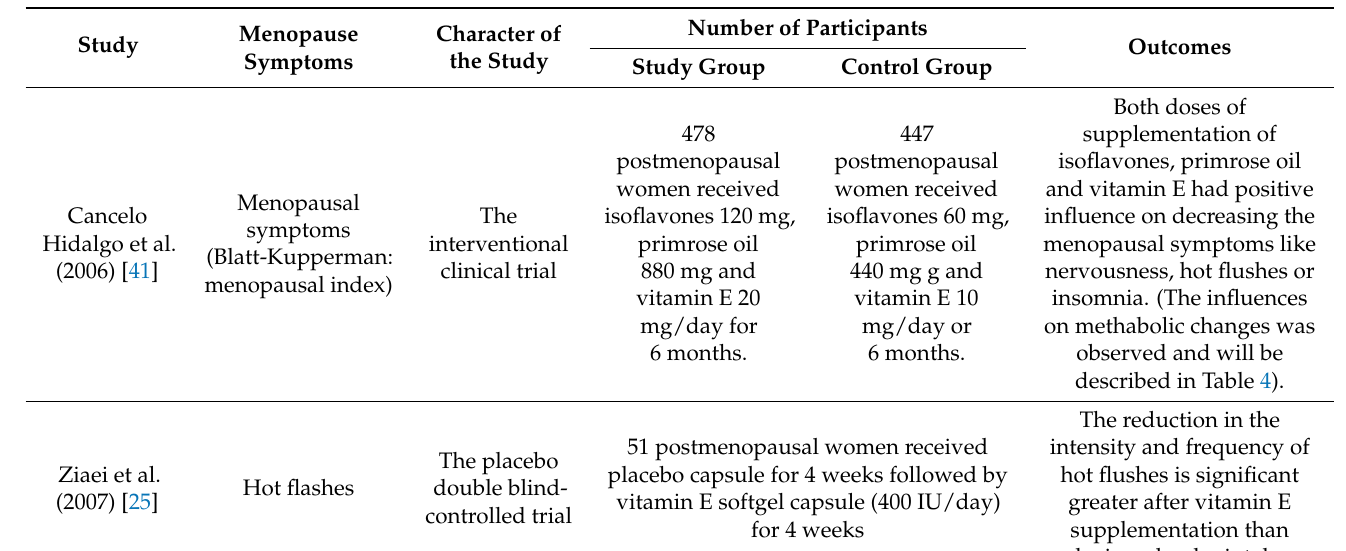
Table 3. Characteristics of included studies concerning vasomotor, neurological and psychiatric symptoms of menopause.